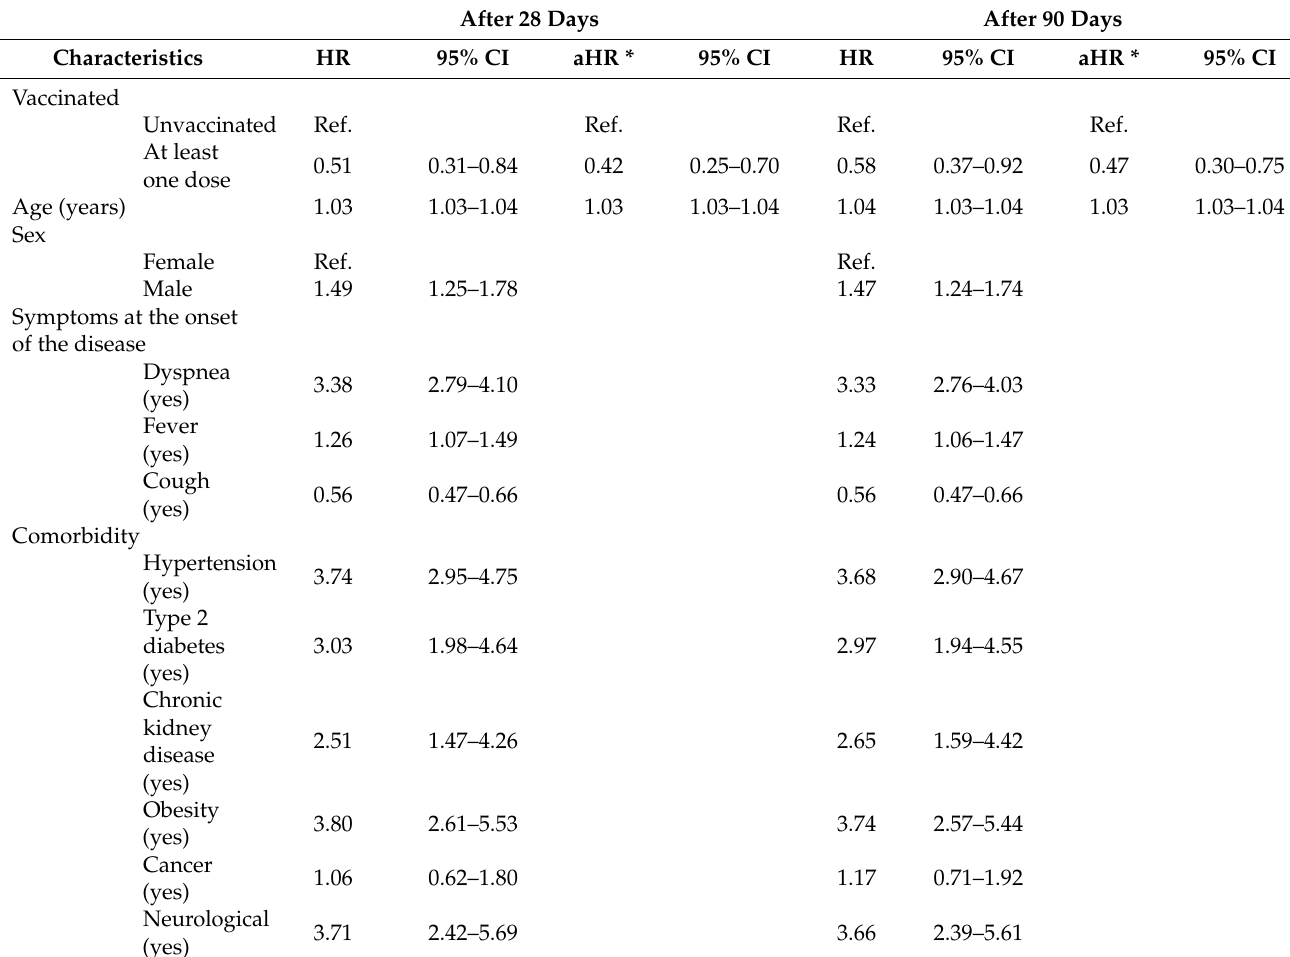
Table 3. Association between COVID-19 vaccination and mortality in multivariate analysis.